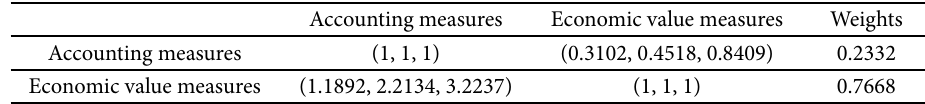
Table 4. The fuzzy evaluation matrix with respect to the goal Accounting